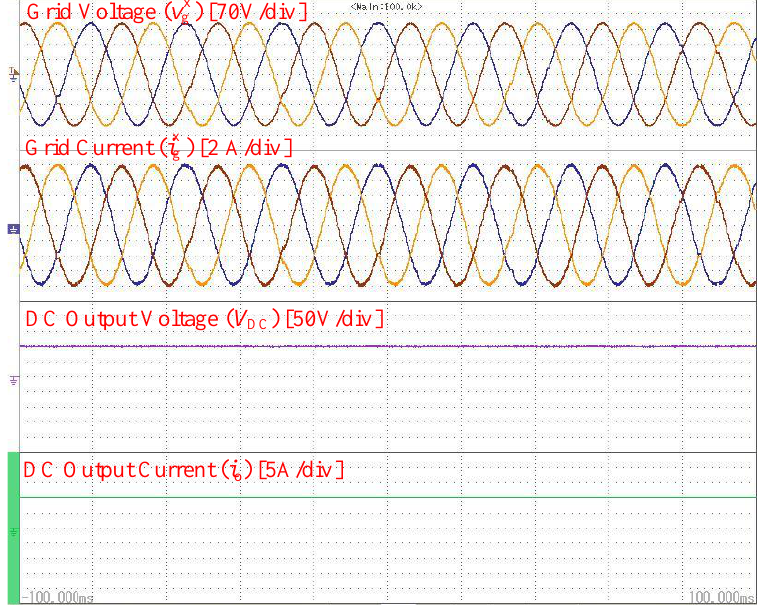
Figure 12. Steady-state experimental results in buck mode operation of the proposed rectifier.